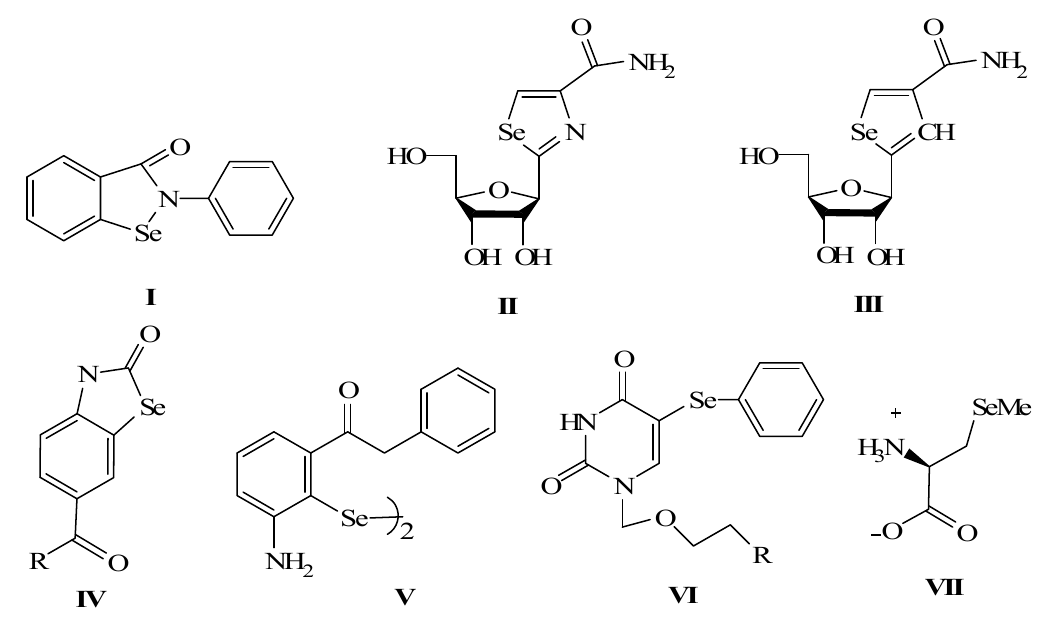
Figure 1. Some biologically active selenium